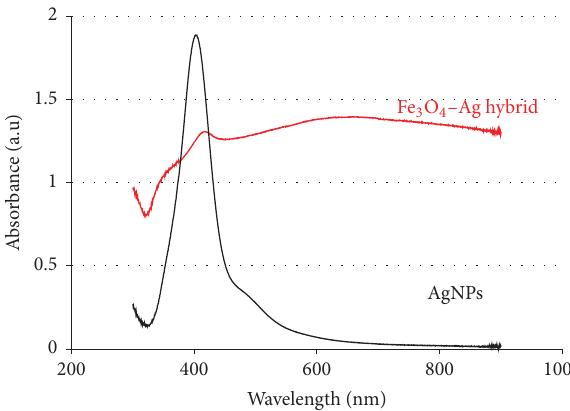
Figure 13: UV-visible absorption spectra of AgNPs and Fe 3 O 4 –Ag hybrid nanoparticles (dispersed in